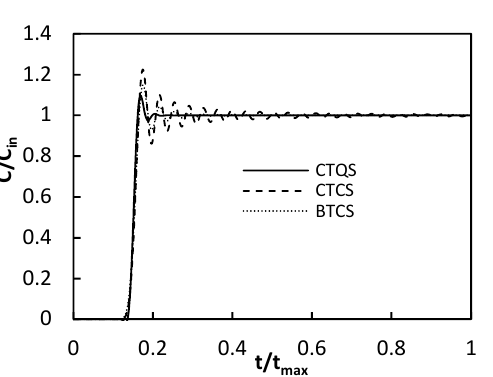
Table 8. Error indices of concentration time series in test case